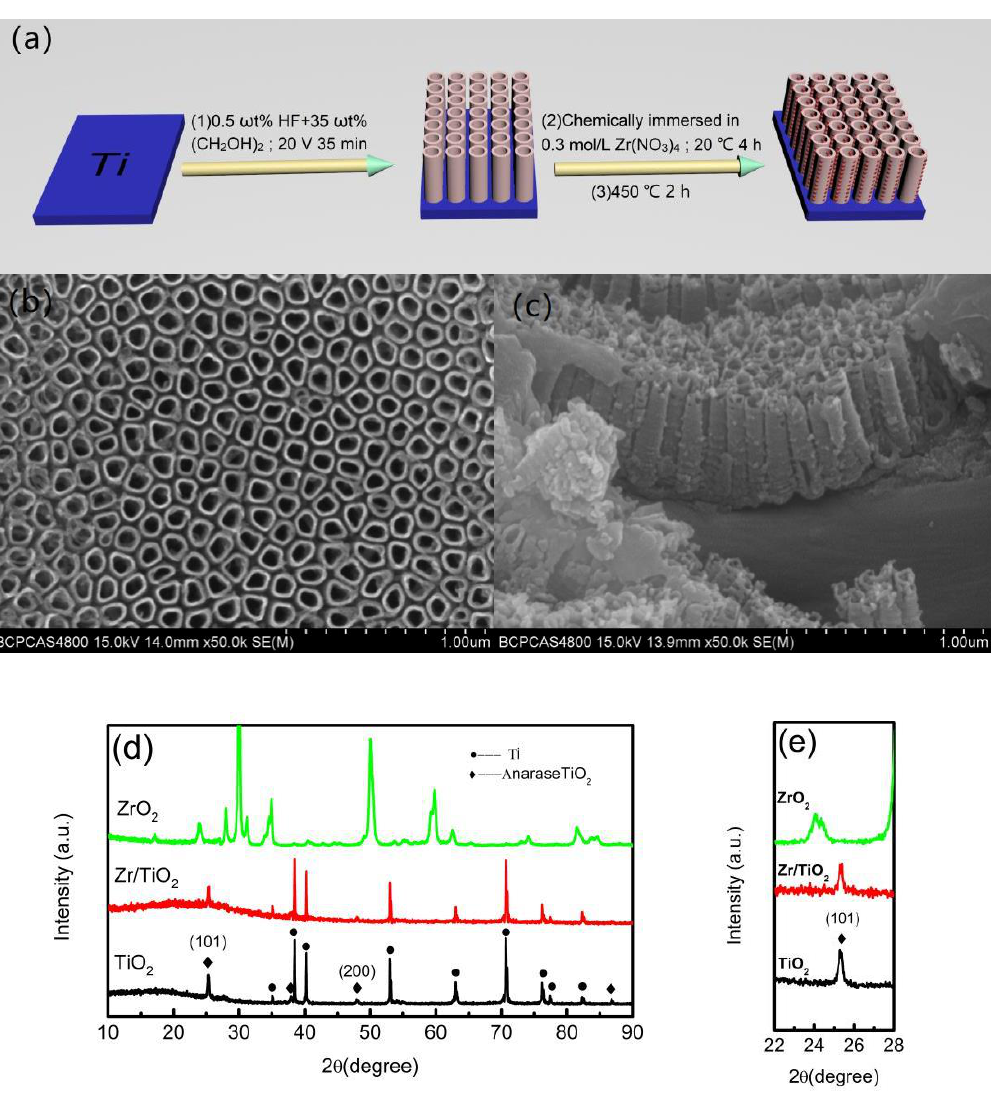
Figure 1. Preparation process ( a ), surface ( b ), and section ( c ) morphologies, and XRD patterns ( d , e ) of anatase Zr/TiO 2 nanotube array electrode.